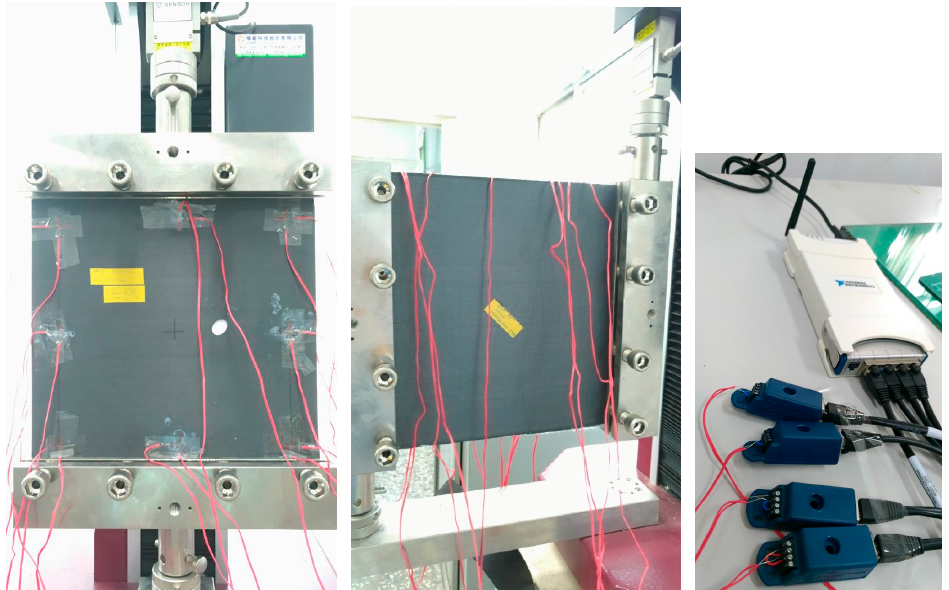
Figure 6. Material test stand (MTS) of hardware-in-the-loop simulation (HILS): Loading mode I and hole identification by using measured strains ( left ); loading mode II and crack (45°) identification ( middle ); Data Acquisition (DAQ) card NI9237—four channels strain measurement ( right ).